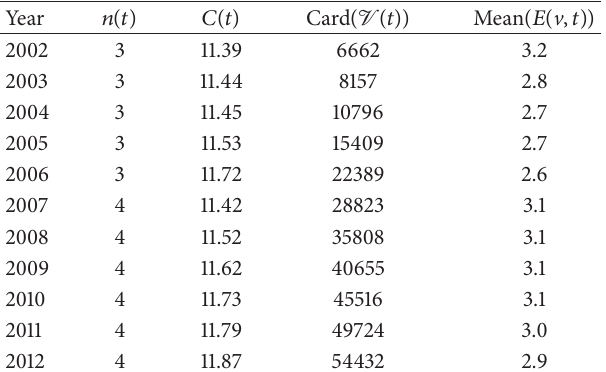
Table 5: Values of 𝑛(𝑡) and 𝐶(𝑡) from 2002 to 2012.